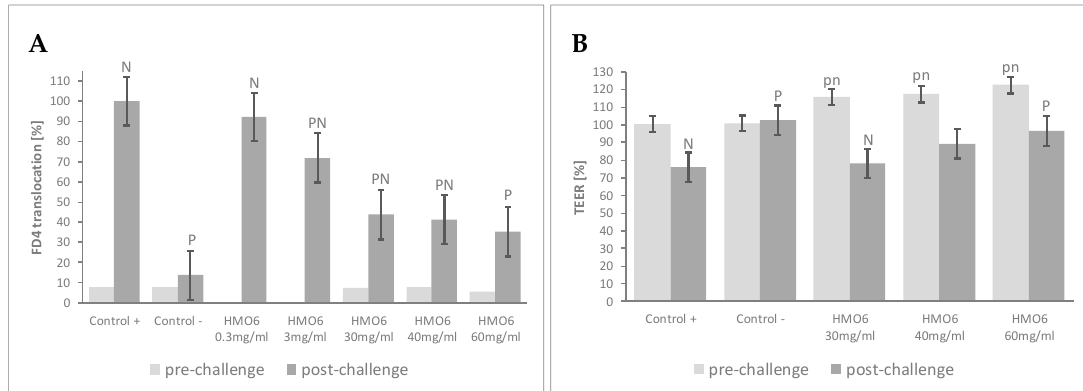
Figure 1. HMO6 confers resistance against inflammation-induced epithelial barrier dysfunction. Dose–response effect of HMO6 on ( A ) FD4 translocation (relative to Control + = 100%) at the end of the 48 h pre-challenge and post-challenge periods, and ( B ) TEER changes (relative to Time 0 h = 100%) during the 48 h pre-challenge and the 48 h post-challenge periods. Controls were non-HMO treated cells and cytokine unchallenged cells (Control − ) and non-HMO treated cells, but cytokine challenged (Control +). Means ± 0.5 x LSD5% are presented, so that two conditions are significantly different if their error bars do not overlap. Significant differences vs. controls are highlighted (P = different from Control +, N = different from Control − ), with capital letters for post-challenge and lowercase for pre-challenge. FD4: 4 KDa FITC-Dextran; HMO6: Blend of 6 human milk oligosaccharides; LSD 5% : Fisher’s least significant difference with α = 5%. The FD4 translocation test showing approximately 60% decrease of inflammation-mediated gut barrier disruption at a dose of 30 mg/mL was selected for the further experiments.